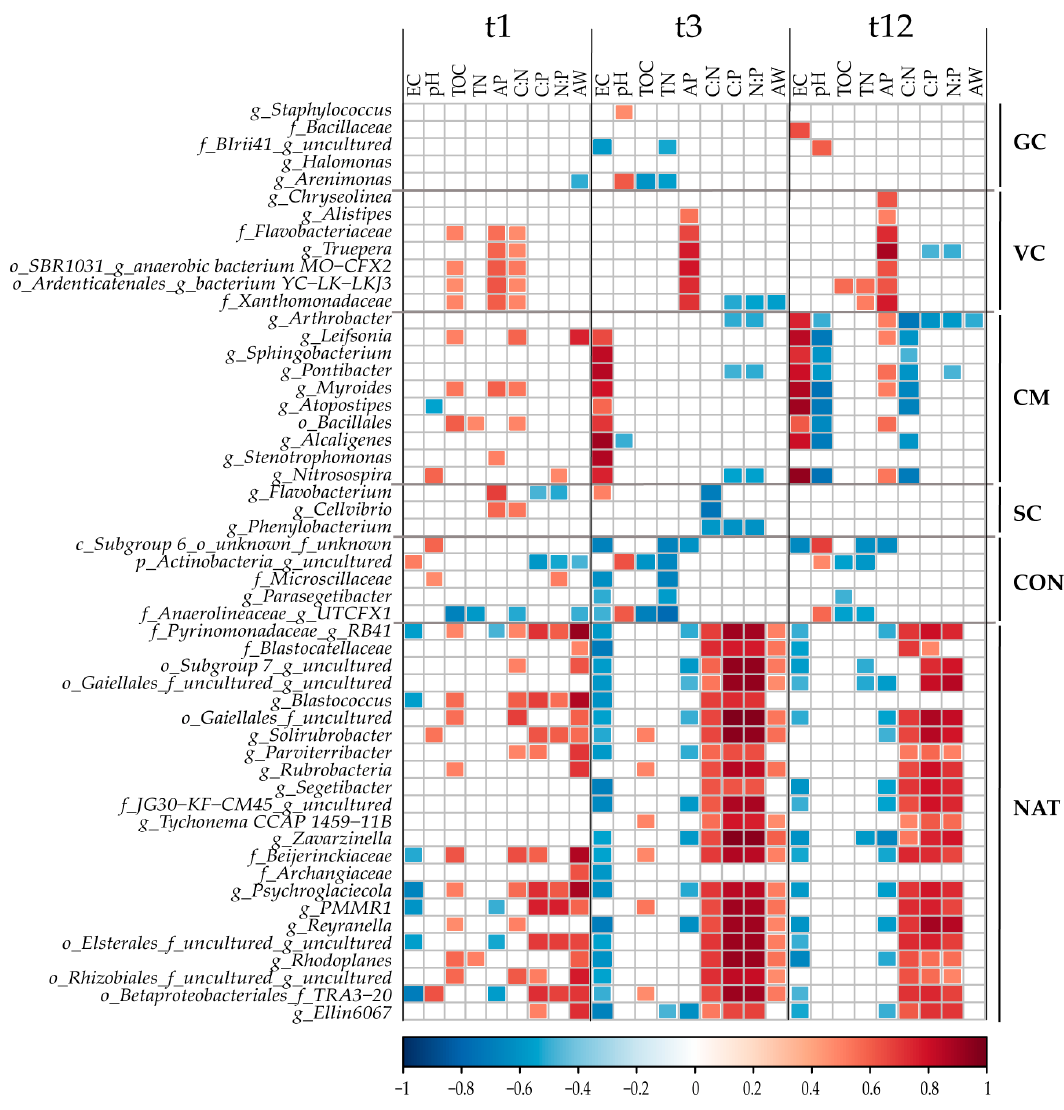
Figure 4. Significant Pearson correlation ( p < 0.05) between soil physico-chemical properties and the groups of bacterial taxa selected as indicators of each restored, control, and natural reference soils, for each sampling campaign (t1, t3, and t12). EC: electrical conductivity; AW: available plant water; TOC: total organic carbon; TN: total nitrogen; AP: assimilable phosphorus; C:N: carbon-to-nitrogen ratio; C:P: carbon-to-phosphorus ratio; N:P: nitrogen-to-phosphorus ratio. GC: greenhouse crop residues compost; VC: vermicompost; SC: organic compost derived from the mixture of chicken and sheep manure; CM: manure from chickens raised on the soil of organic farms; CON: unamended control soils; NAT: natural reference soil.